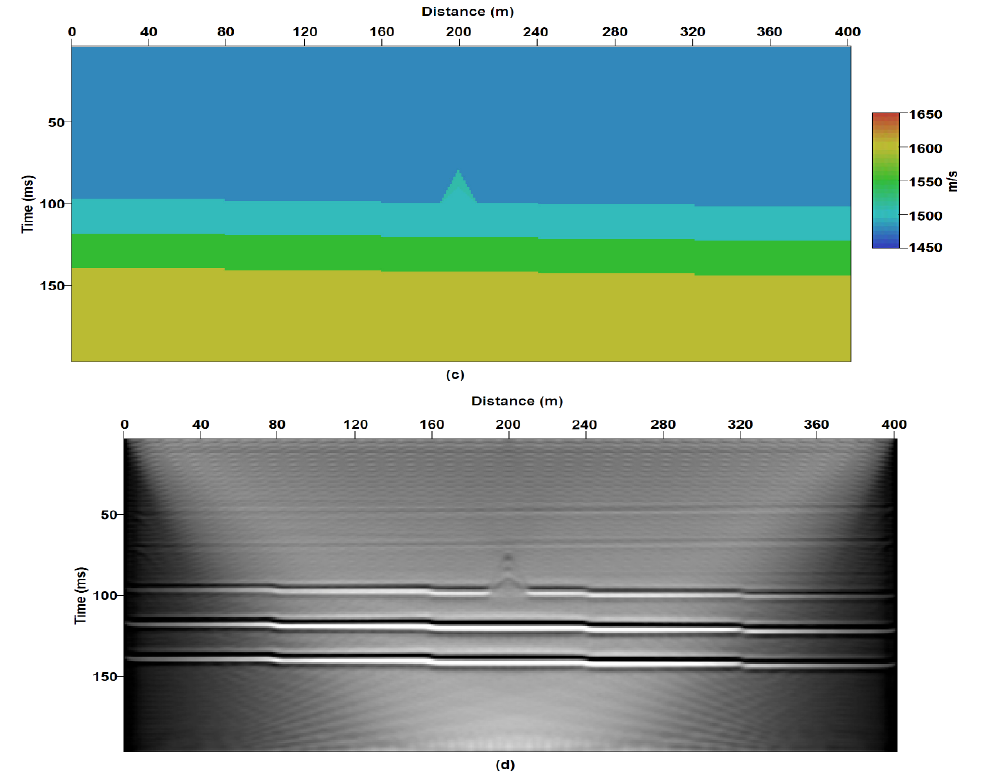
Figure 8. Numerical imaging results: ( a ) input velocity model of the negative acoustic variance with the mound model; ( b ) RTM image of ( a ); ( c ) input velocity model of the positive acoustic variance with the mound model; ( d ) RTM image of ( c ).